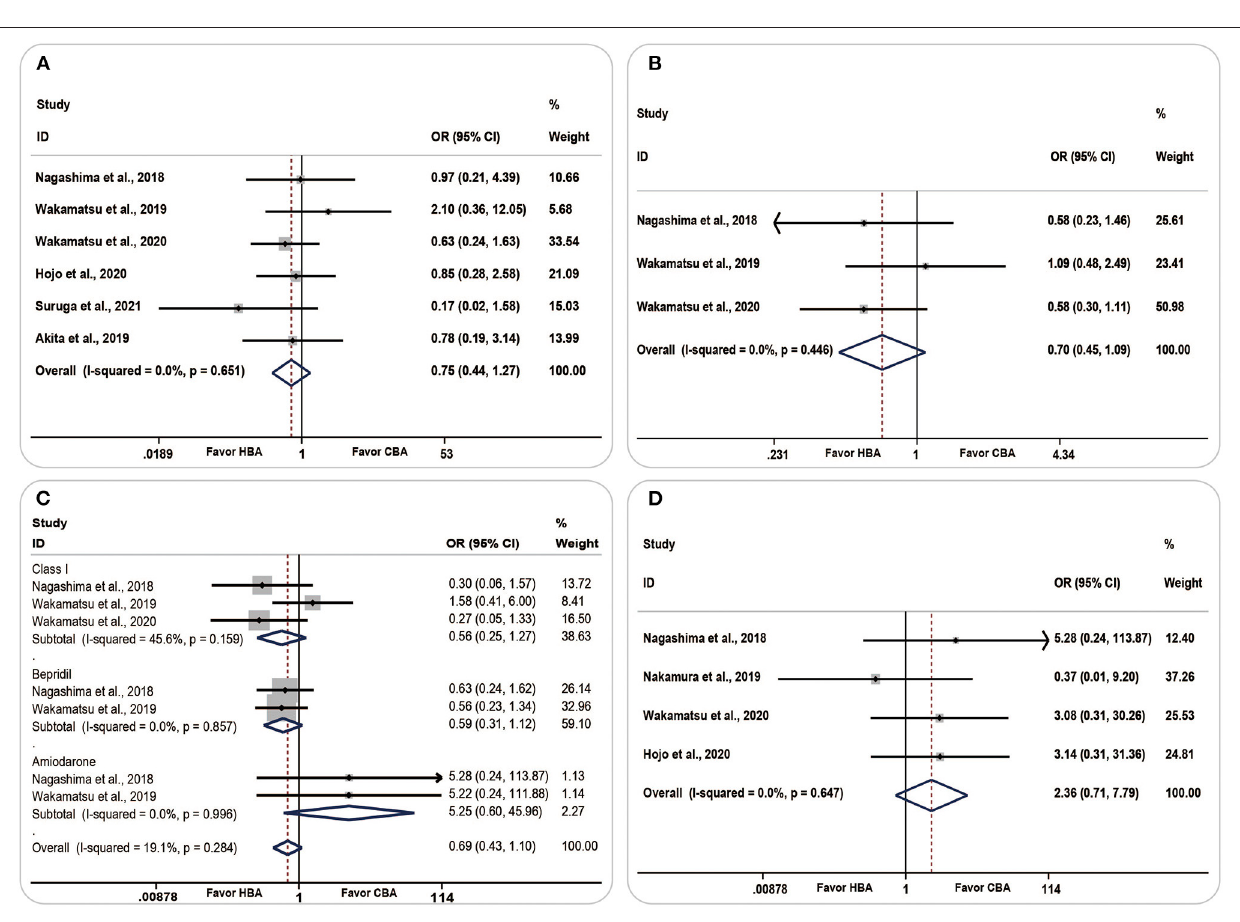
FIGURE 7 | Forest plots showing the association between clinical outcomes and ablation strategy. (A) Atrial fibrillation recurrence, (B) antiarrhythmic therapy, (C) antiarrhythmic drug therapies in detail, (D) complications. CBA, cryoballoon ablation; HBA, hot balloon